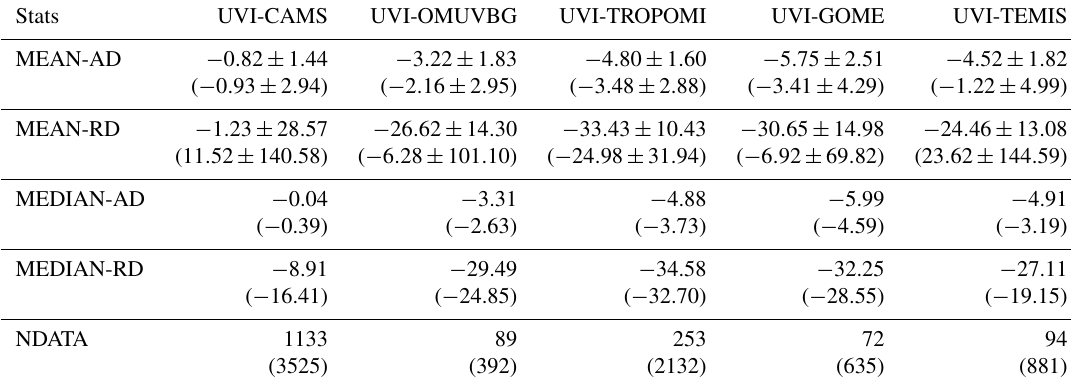
Table A3. Mean and median absolute and relative differences between CS-UVI satellite/model measurements and CS-UVI-RADIO at Mahé. Mean and median absolute and relative differences between ALL-SKY-UVI satellite/model measurements and ALL-SKY-UVI-RADIO at Mahé are in parentheses.